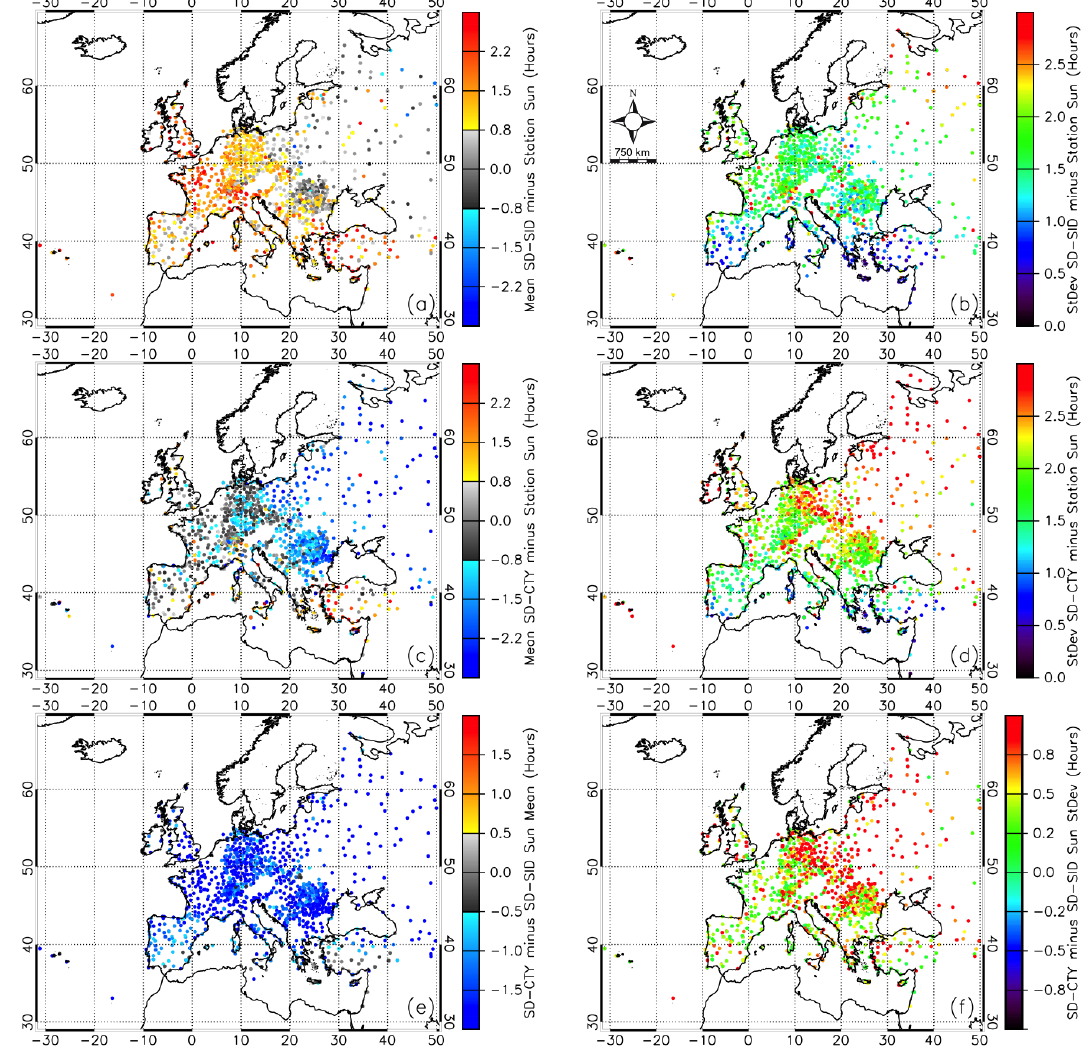
Figure 11. Maps showing ( a ) mean daily SD-SID minus station difference; ( b ) standard deviation of daily SD-SID minus station differences; ( c ) mean daily SD-CTY minus station difference; ( d ) standard deviation of daily SD-CTY minus station differences; ( e ) mean daily SD-CTY bias minus SD-SID bias ( i.e. , panel (c) minus panel (a)) and ( f ) mean daily SD-CTY standard deviation minus SD-SID standard deviation ( i.e. , panel (d) minus panel (b)) at each station for July